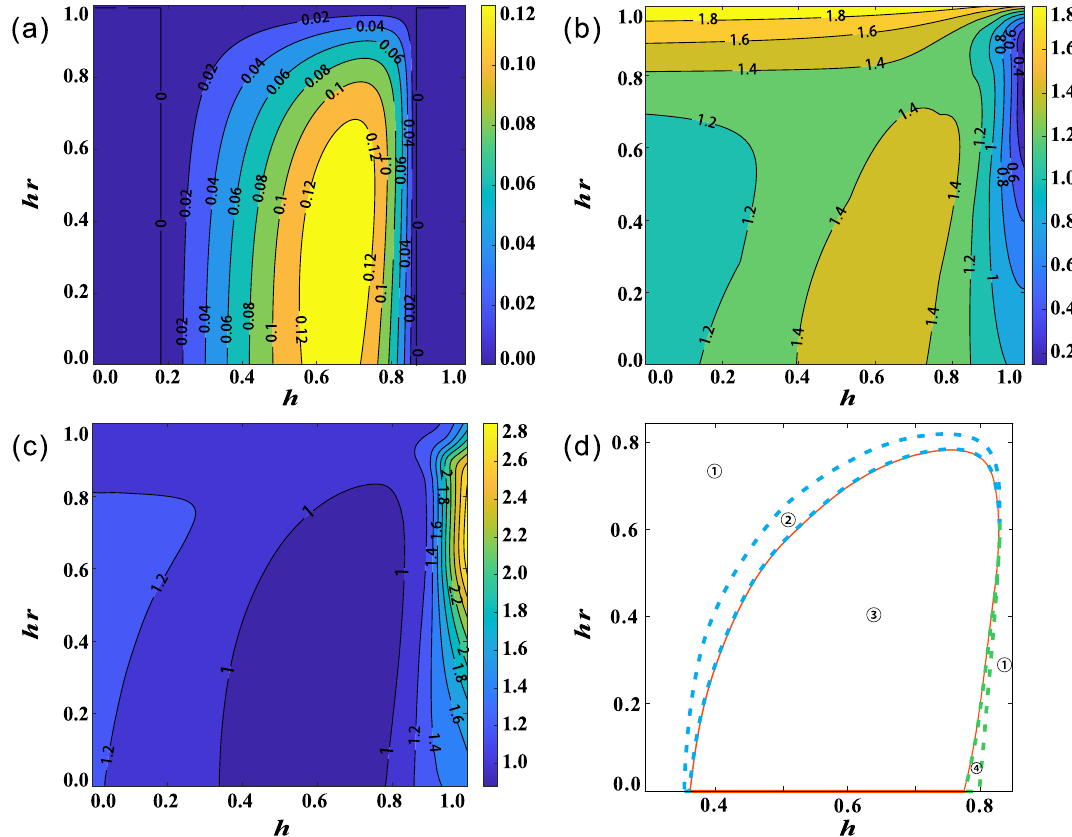
Figure 5. (Color online) Revival effects of nonlocal quantum correlations in uncorrelated SGAD channel 0 ). ( a ) The contour plot of concurrence C . ( b ) The contour plot of Bell parameter B . ( c ) The contour plot ( µ = of critical radius R AB . ( d ) The steering regions are parameterized by h and hr . h and hr represent the strength of WM and QMR,